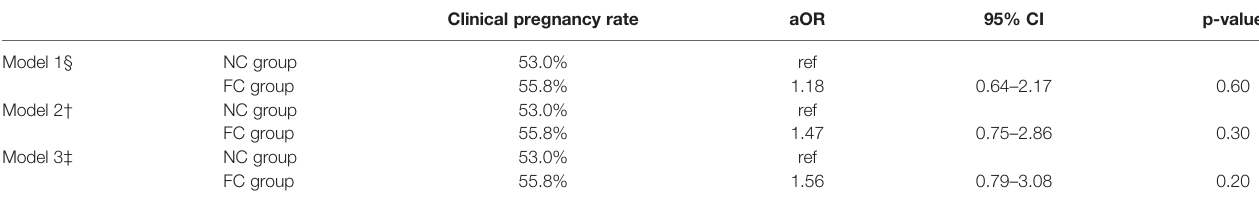
TABLE 4 | Association of HCG triggering GnRHa-induced FC and clinical pregnancy analyzed by three multivariate models adjusted with different confounders. Clinical pregnancy